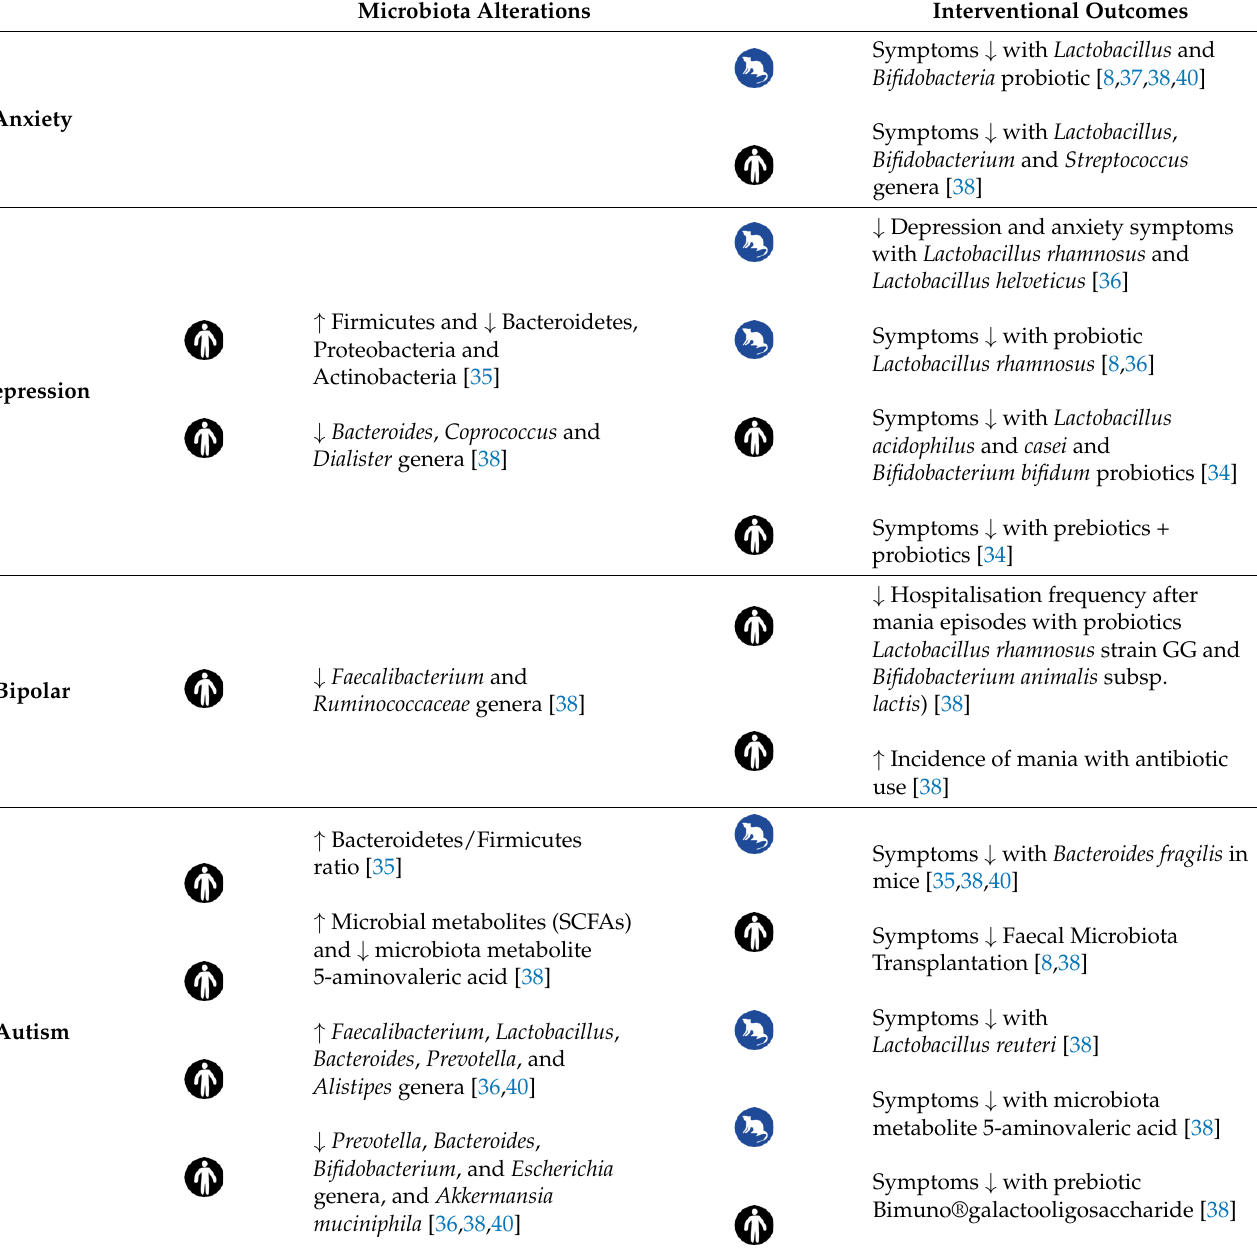
Table 1. Microbiota-based interventions and their effect on the various neuropsychiatric disorders.